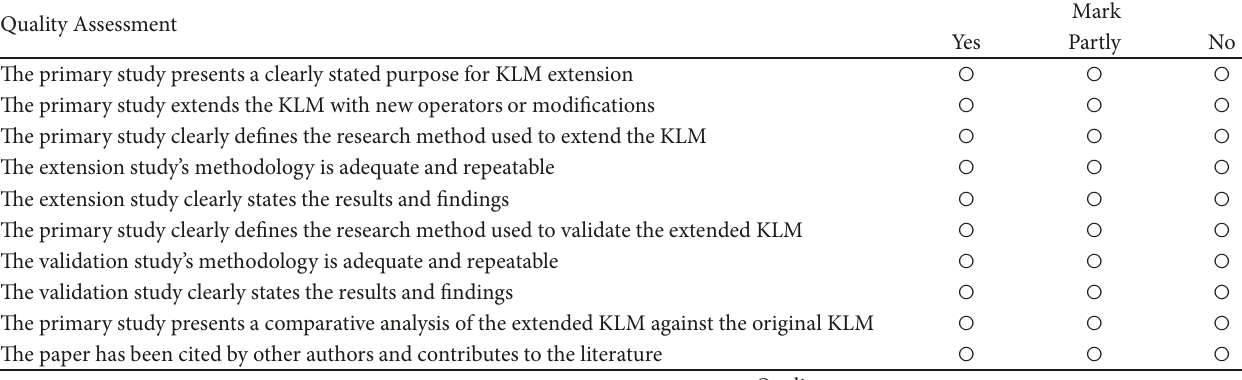
Table 14: Quality assessment